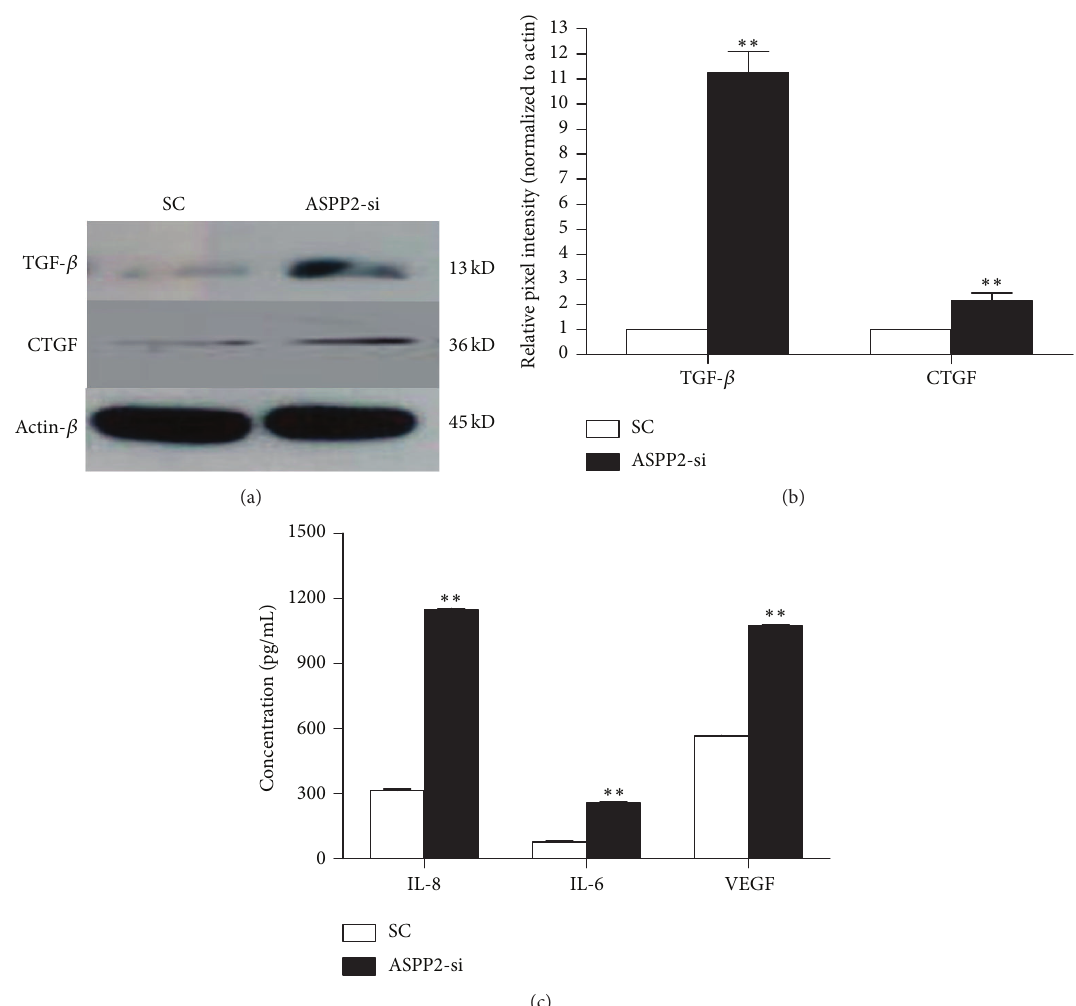
Figure 5: Effects of ASPP2 on the protein expression of EMT-related cytokines of ARPE-19 cells. After transfection with either scrambled control-siRNA or ASPP2-siRNA for 48 hours, protein levels of ARPE-19 cells were analyzed by western blot using antibodies against TGF- 𝛽 and CTGF (a). 𝛽 -actin was used as a loading control. Representative results obtained in three independent experiments are shown. Column diagrams and bars represent the ratio of the scanned immunoblots of TGF- 𝛽 and CTGF to 𝛽 -actin (b). SC was set to 100%. Meanwhile, concentrations of IL-8, IL-6, and VEGF in the culture supernatants of ARPE-19 cells were quantified with the CBA assay (c). Data are shown as the mean ± SD, 𝑛 = 3 experiments. ∗∗ 𝑃 < 0.01 versus SC group. SC, scrambled control-siRNA-transfected cells; ASPP2-si, ASPP2-siRNA- transfected